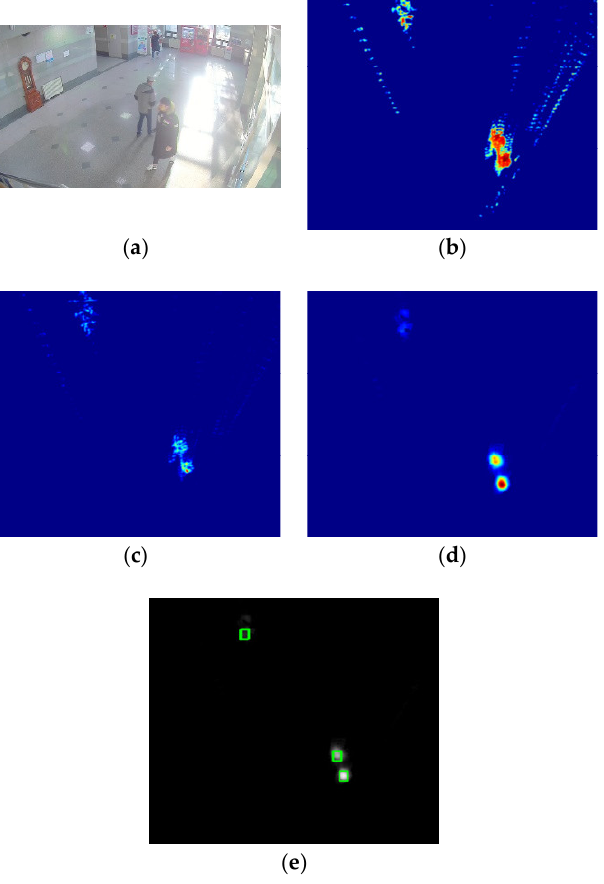
Figure 9. Top-view projection results: ( a ) color image; ( b ) height map; ( c ) occupancy map; ( d ) likelihood map; and ( e ) detection result.